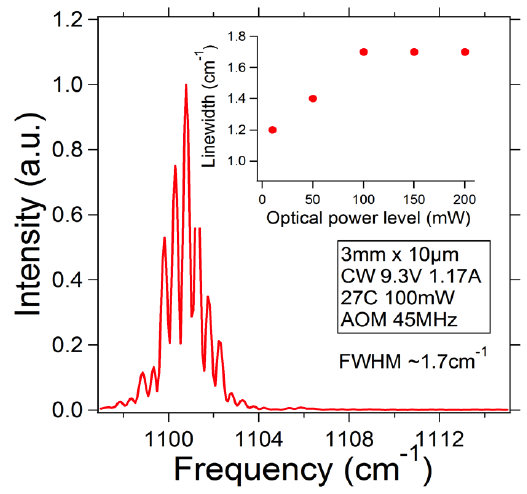
Figure 3. Emission line of the CW AOM-controlled QCL. Inset shows linewidth variation with change in optical power.